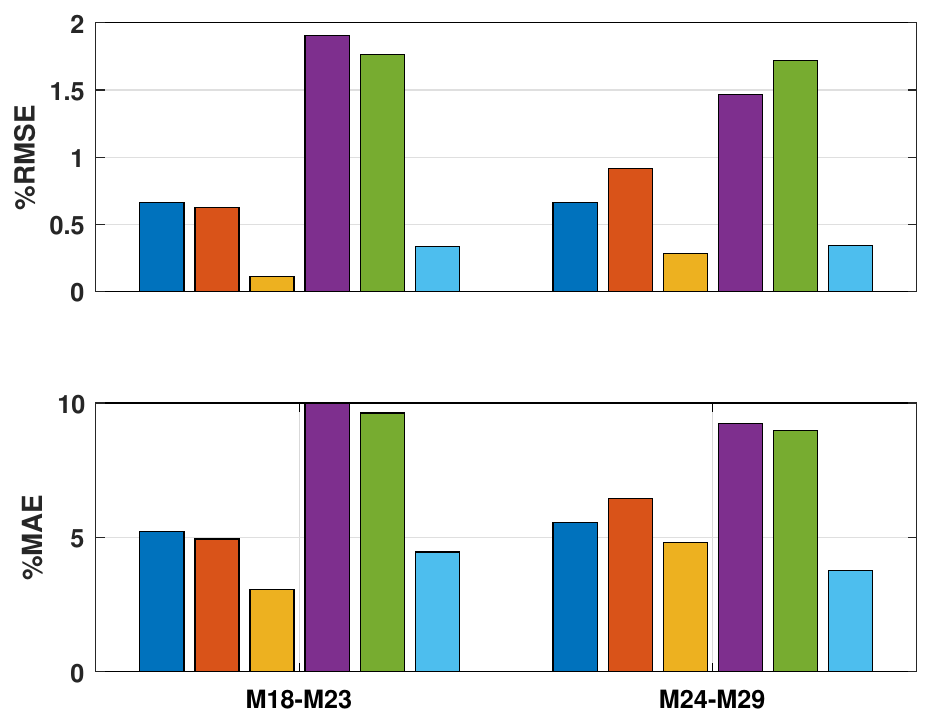
Figure 9. Comparison of different models under clear and cloudy days with GD, Sat, and Sat-GD inputs, when time steps =